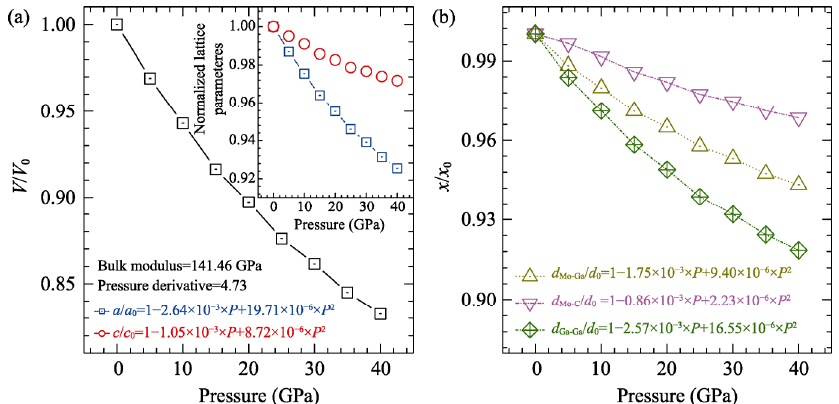
Fig. 3 Pressure dependence of (a) the normalized cell volume V / V 0 as well as normalized lattice parameters a / a 0 , b / b 0 , and c / c 0 of Mo 2 Ga 2 C and (b) normalized bond length d / d 0 in Mo 2 Ga 2